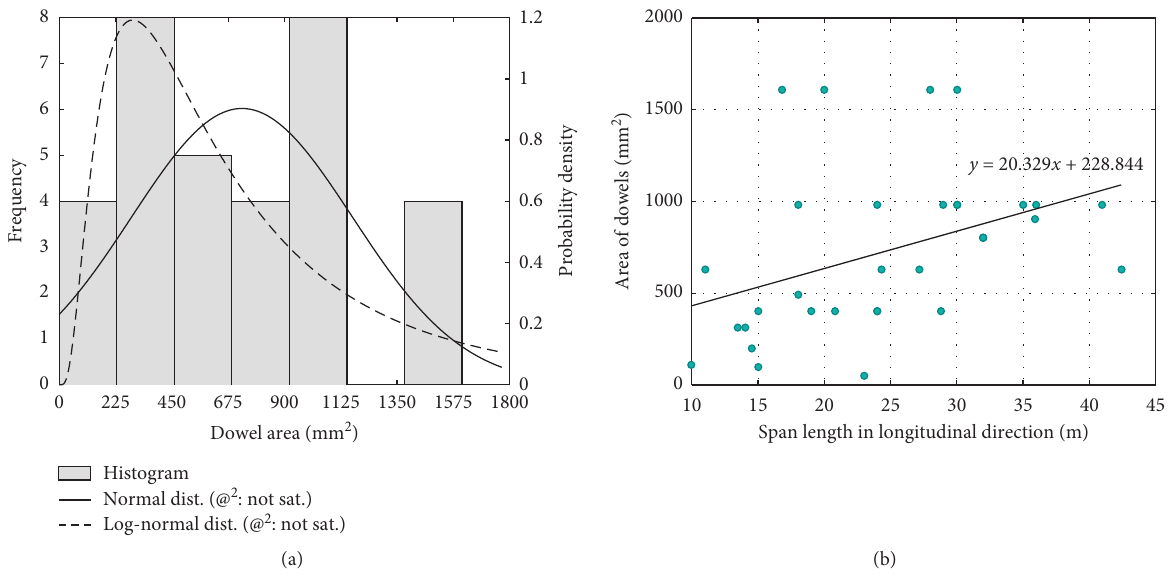
Figure 24: Dowels area: (a) histogram and probability distributions associated with the area of dowels and (b) evolution with the span length along the longitudinal direction.